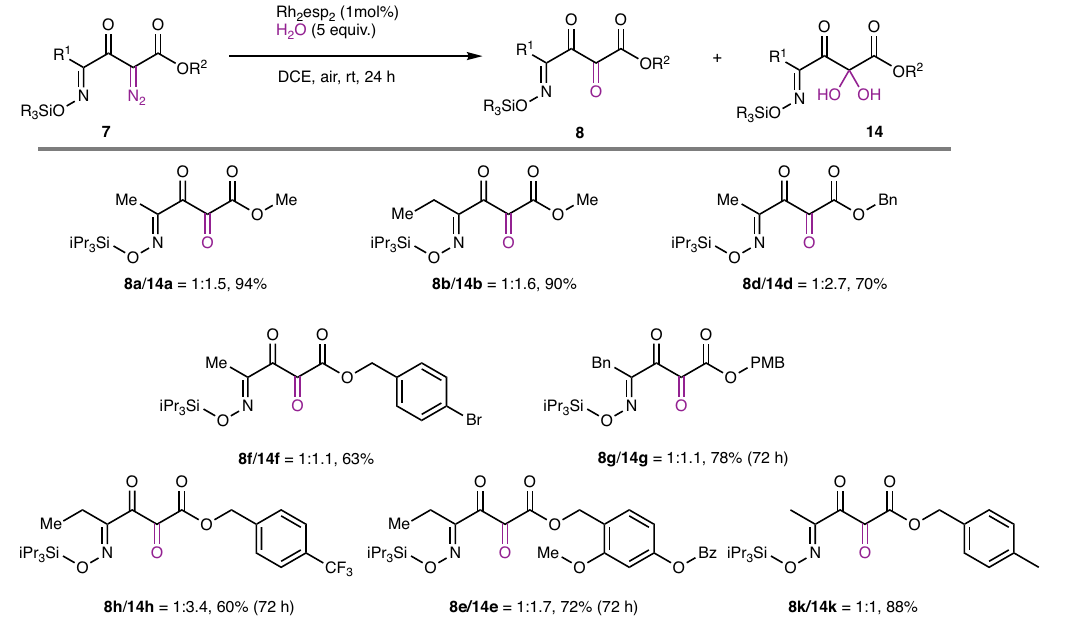
Fig. 6 | Formation of 1,2,3,4-tetracarbonyl compounds. Rhodium-catalyzed reaction of oximes 7 with water and aerobic